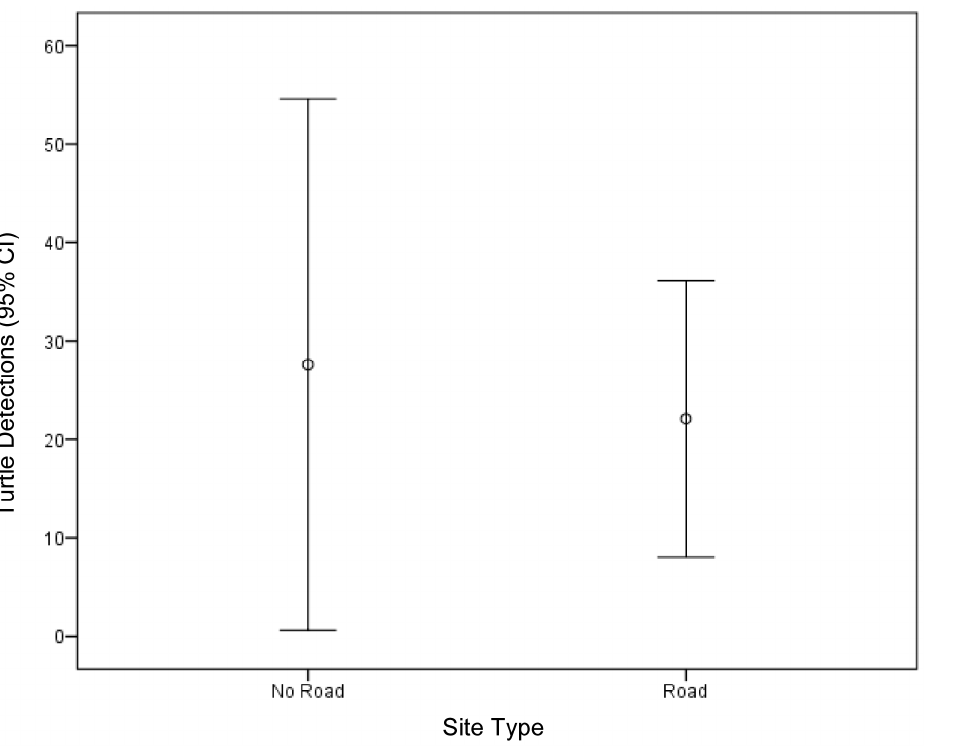
Figure 3. Mean Turtle Detections at Road and No Road sites. Mean (untransformed) Turtle Detections and 95% confidence intervals (CI) at Road and No Road sites. Note, there were two ponds at the No Road sites where no turtles were observed and one pond where 121 turtles were observed (Table S2 and S3). doi:10.1371/journal.pone.0098414.g003 weight: t = 0.202, df = 30, p = 0.841; Figure 6). In contrast, and